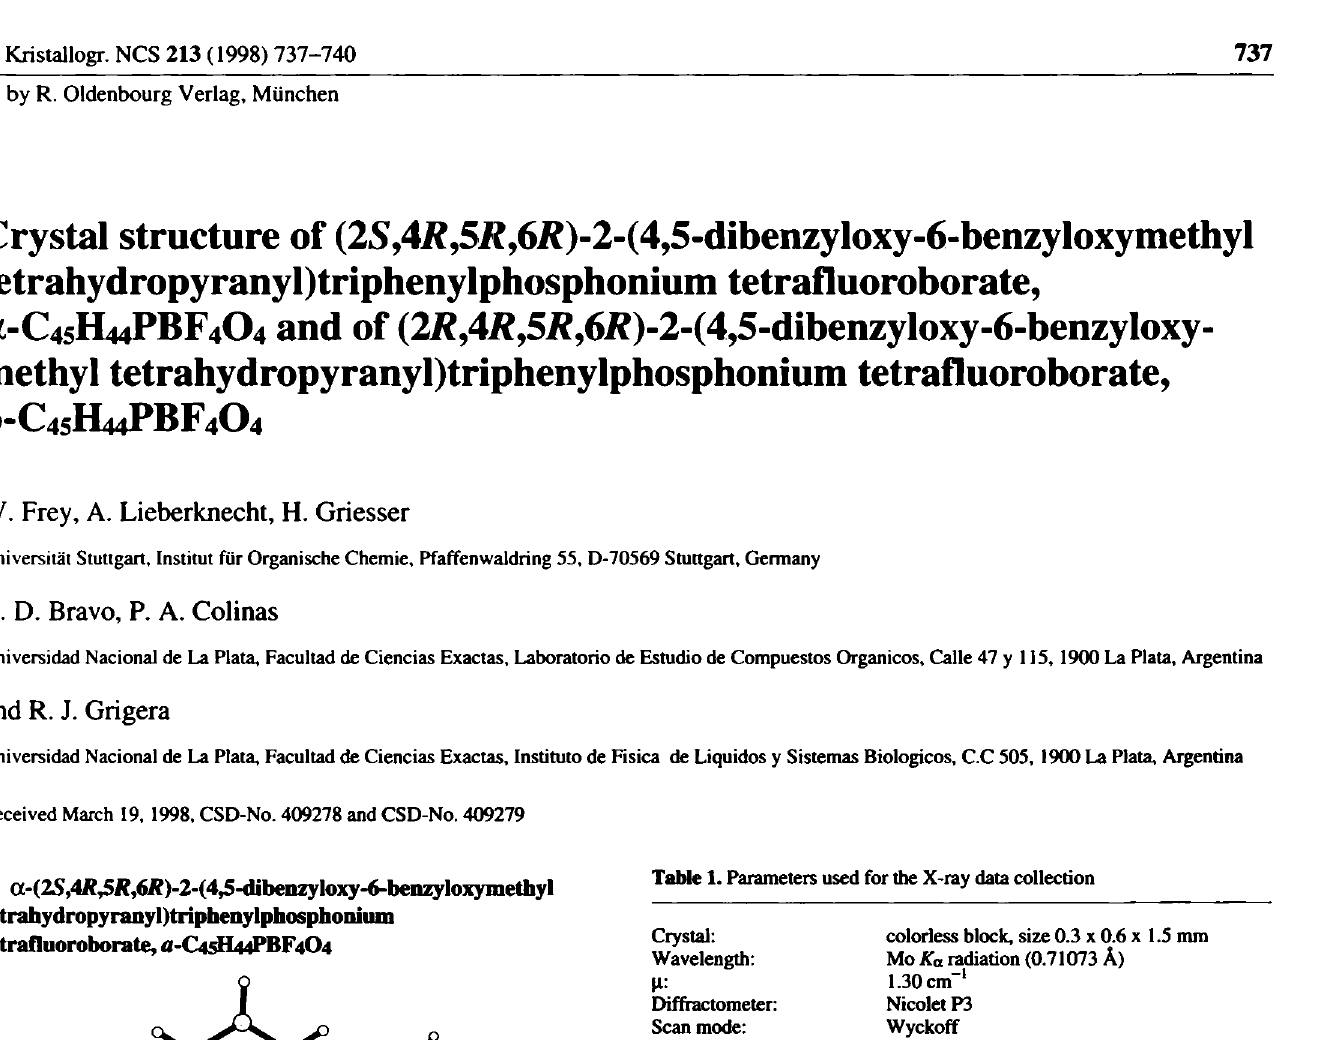
Table 2. Final atomic coordinates and displacement parameters (in